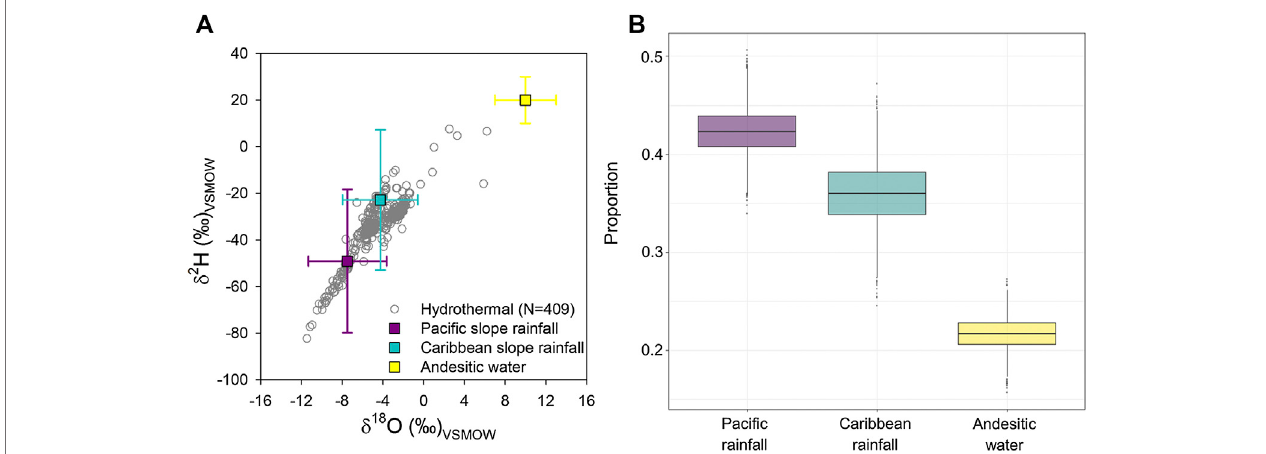
FIGURE 13 | Andesitic water contribution. (A) Dual isotope diagrams for hydrothermal mixtures (gray empty circles) and mean values (error bars) of three end- members: Paci fi c rainfall (purple), Caribbean rainfall (cyan), and andesitic water (yellow) as proposed by Giggenbach (1992). (B) Source contribution (as proportion) box plots. Figure adapted using data from Ramírez-Leiva et al.